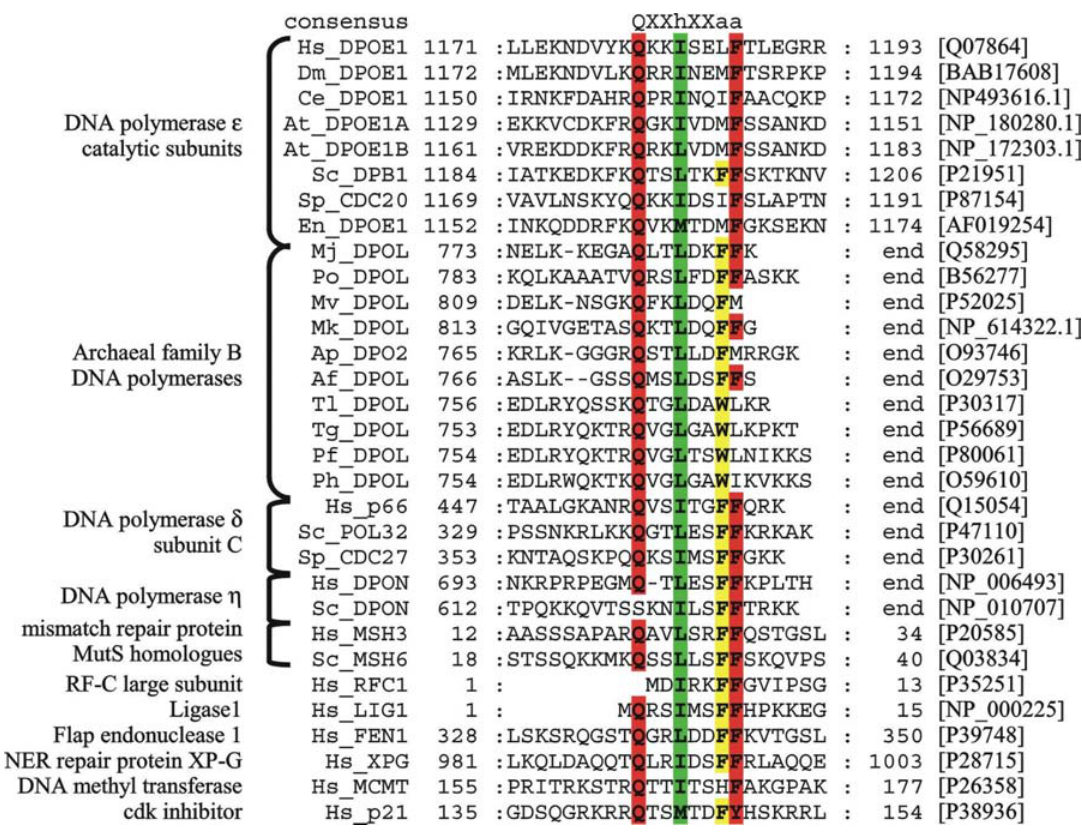
FIGURE 3 . A conserved PCNA interaction site among Pol ε and archaeal Pols of family B. The conserved PCNA-interacting sites of Pol ε , archaeal Pols of family B, Pol δ subunit C, Pol η , as well as representative replication and cell cycle regulating proteins are aligned. Species abbreviations are Hs – Homo sapiens ; Dm – Drosophila melanogaster ; Ce – Caenorhabditis elegans ; At – Arabidopsis thaliana ; Sc – Saccharomyces cerevisiae ; Sp – Schizosaccharomyces pombe ; En – Emericella nidulans ; Mj – Methanococcus jannaschii ; Po – Pyrodictium occultum ; Mv – Methanococcus voltae ; Mk – Methanopyrus kandleri ; Ap – Aeropyrum pernix ; Af – Archaeoglobus fulgidus ; Tl – Thermococcus litoralis ; Tg – T. gorgonarius ; Pf – Pyrococcus furiosus ; Ph – P. horikoshii . Genbank accession numbers are indicated next to each